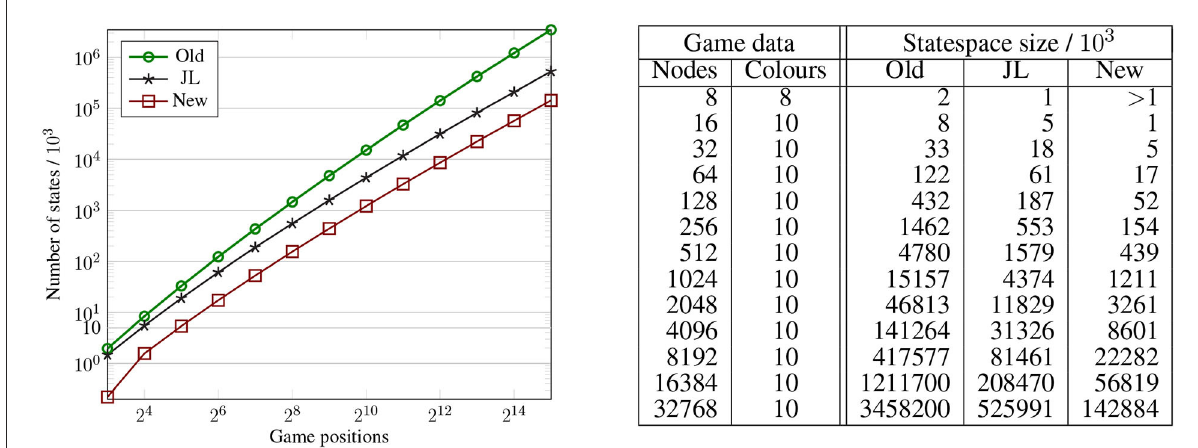
FIGURE1 Size of the statespace for games with a fixed number of colors on a logarithmic scale.